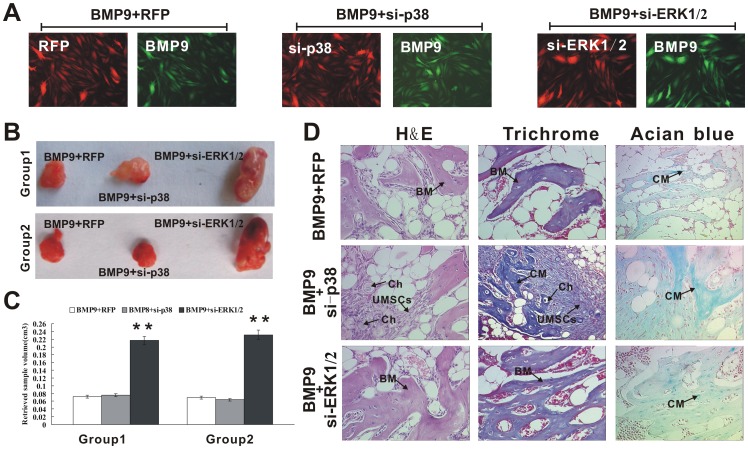
Knockdown of p38 and ERK1/2 leads to opposing effects on BMP9-indcued ectopic bone formation.(A) Co-infection efficiency of Ad-BMP9 and AdR-si-p38 (or AdR-si-ERK1/2). C3H10T1/2 cells were co-infected with Ad-BMP9 and AdR-si-p38 (or AdR-si-ERK1/2). At 24 hrs post co-infection, the co-infection efficiency was determined under a fluorescence microscope. (B) Macrographic images of ectopic bone mass. (C) Total volume of retrieved samples. “**”, p<0.01 (vs. control groups) (D) Histological stains of retrieved samples. Retrieved tissues were decalcified, fixed in 10% formalin overnight, and embedded in paraffin. Serial sections of the embedded specimens were stained with H&E, Masson’s Trichrome stain and Alcian Blue stain. BM, Bone Matrix; Ch, Chondrocyte; UMPCs, Undifferentiated mesenchymal progenitor cells; CM, Cartilage Matrix. Magnification, ×150.